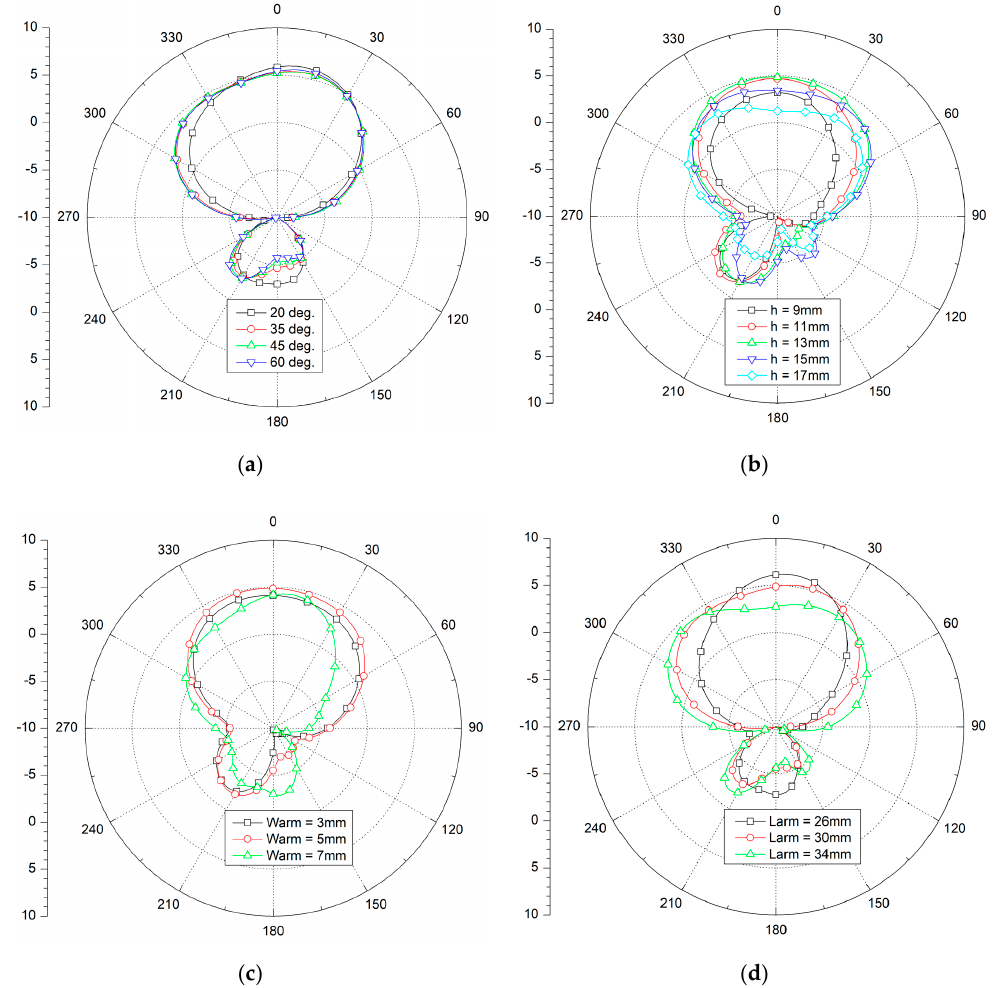
Figure 5. Simulated radiation patterns according to the different ( a ) inclined angle, θ , on the xz-plane ( b ) height, h , on the yz-plane, ( c ) width, Warm, on the xz-plane, and ( d ) length, Larm, on the xz-plane of the inverted-V arms. Here, different radiation planes are plotted for the best view of variation.